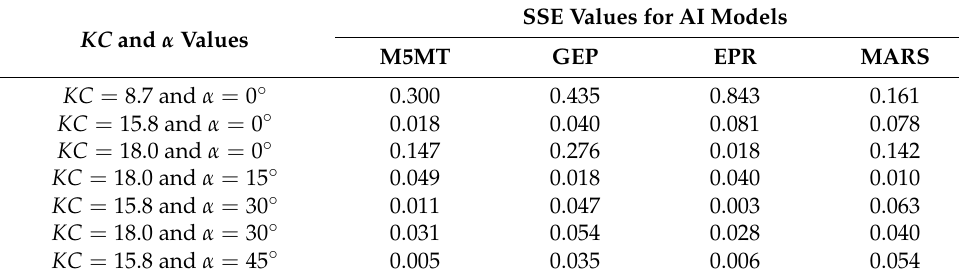
at various e / D ratios. H